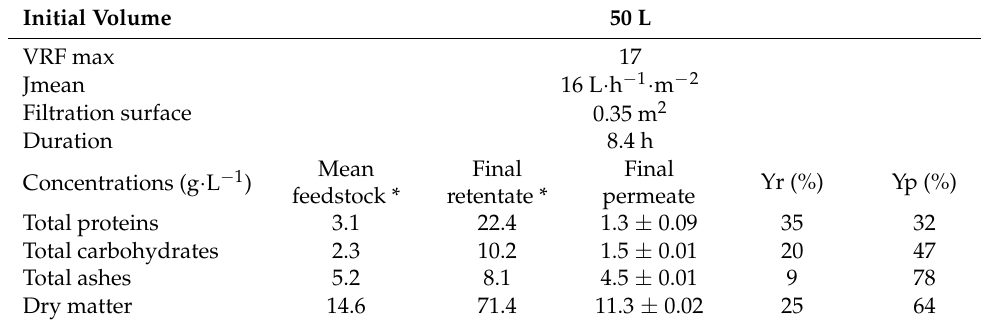
Table 1. Mass balance carried out following the microfiltration step.